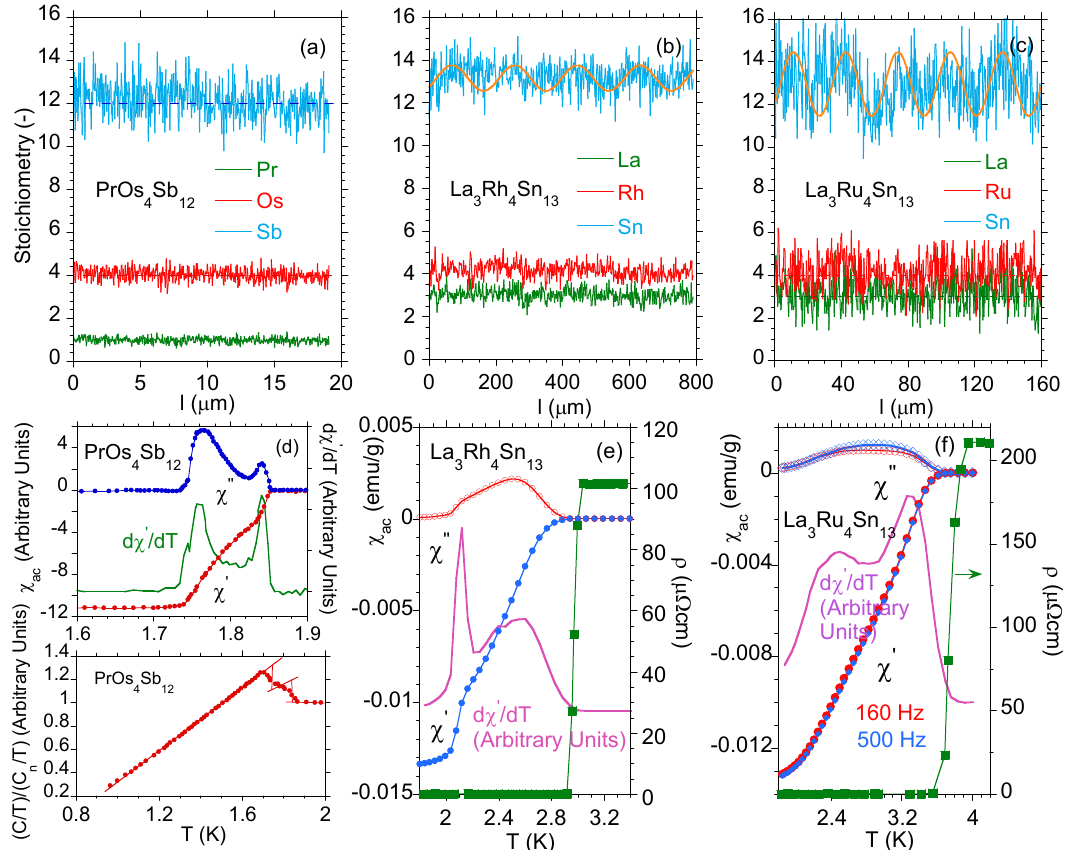
Figure 1. Variation in stoichiometry over the length of the sample: ( a ) for PrOs 4 Sb 12 , the correct stoichiometric ratio of Pr:Os:Sb from EDS analysis is 1.00:4.0:12.70, ( b ) for La 3 Rh 4 Sn 13 , the correct stoichiometric ratio of La:Rh:Sn is 3.12:4.0:12.98, ( c ) for La 3 Ru 4 Sn 13 , the correct stoichiometric ratio of La:Ru:Sn is 3.09:4.0:12.78. The yellow curve in panel ( b , c ) is a rough approximation of the fluctuations l ) , where ∆ l = 190 µ m for La 3 Rh 4 Sn 13 in Sn content around the mean Sn content by Λ sin ( 2 π ∆ l and ∆ l = 30 µ m for La 3 Ru 4 Sn 13 . ∆ l expresses a diameter of the extent of strong fluctuations in